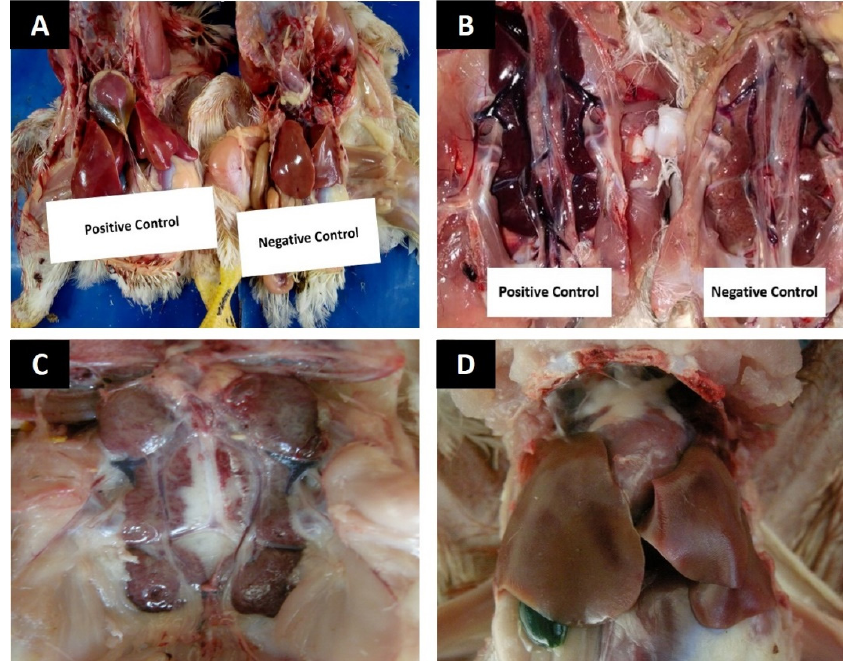
Figure 1. Photographs showing gross lesions in various organs ( A ) Swollen and congested liver from group B, while liver from group A has normal size and color ( B ) kidneys showing severe congestion and swelling from group B, while kidney has a normal appearance in group A ( C ) Kidney showing moderate swelling and congestion in group D ( D ) Liver showing mild congestion and swelling in group C.